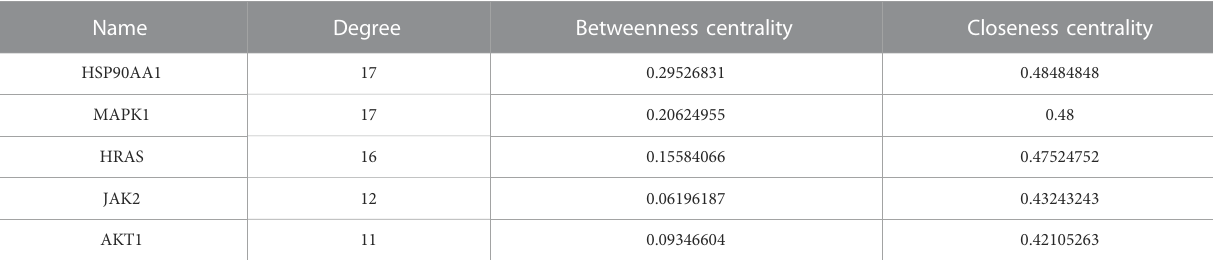
TABLE 2 Top fi ve target information of the PPI